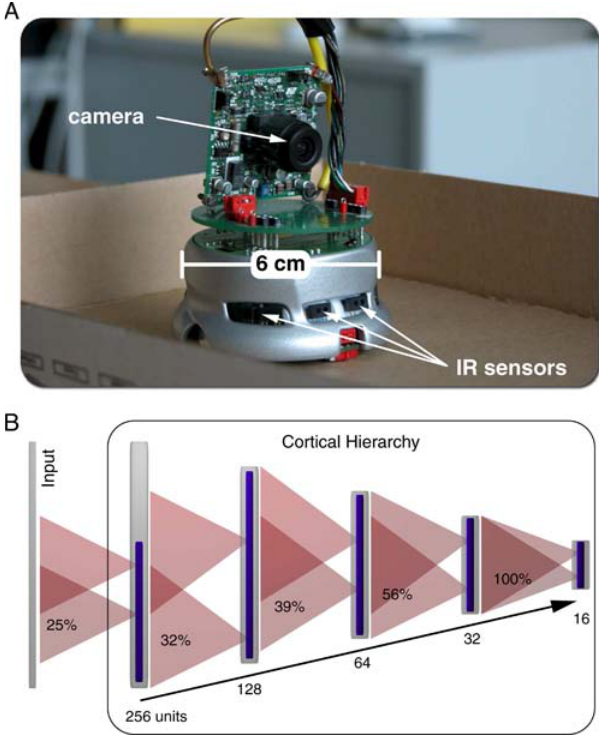
Figure 1. The Micro-Robot Khepera and the Neural Network Structure Used for Sensory Processing (A) A camera mounted on top of the cylindrical body provides the visual input that is processed by our model of the ventral visual system. The infra-red (IR) sensors are used for obstacle avoidance during exploration of a real-world office environment within an arena of approximately 31 3 22 cm 2 . (B) Diagram showing the hierarchical network comprising five levels of identical computational units. Units are arranged uniformly within a two- dimensional square lattice, and their number per level decreases with a constant factor of 0.5 moving up the hierarchy. Each efferent unit receives input from a topographically aligned square region within the afferent level (red connectivity) and connects laterally to all the units in the same level with which it shares feed-forward input (blue connectivity). The average relative size of a unit’s feed-forward arbor within the afferent level (as given in percentages), and consequently also the lateral degree of connectivity, increases with the hierarchical level and reaches 100% for the units at the highest level. The input to the network has a resolution of 16 3 16 pixels. DOI: 10.1371/journal.pbio.0040120.g001